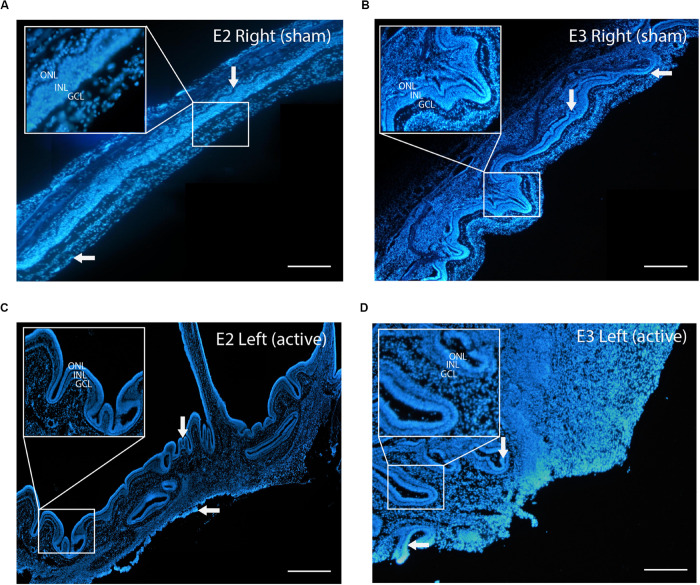
Proliferative vitreoretinopathy (PVR) to the implanted ESF substrate. (A,B) Bisbenzimide staining of the retina dissected from the right eyes of the E2 (left) and E3 (right) pigs that were sham-implanted with the ESF substrate (n = 2). (C,D) Bisbenzimide staining of the retina dissected from the left eyes of the E2 (left) and E3 (right) pigs that were implanted with the ESF-based polymeric device. Upper insets: structure of the retinal layers at higher magnification. In all images, a marked PVR that includes the formation fibrin and curling of the retina is present, witnessing an intense inflammatory reaction to ESF-containing devices. Ocular media opacities were also found by indirect ophthalmoscopy. These phenomena correlate with the complete loss of the ff-ERG signals (see Figure 3). Downward arrow: curling of the retina. Leftward arrow: formation of fibrin. Scale bars, 150 μm.